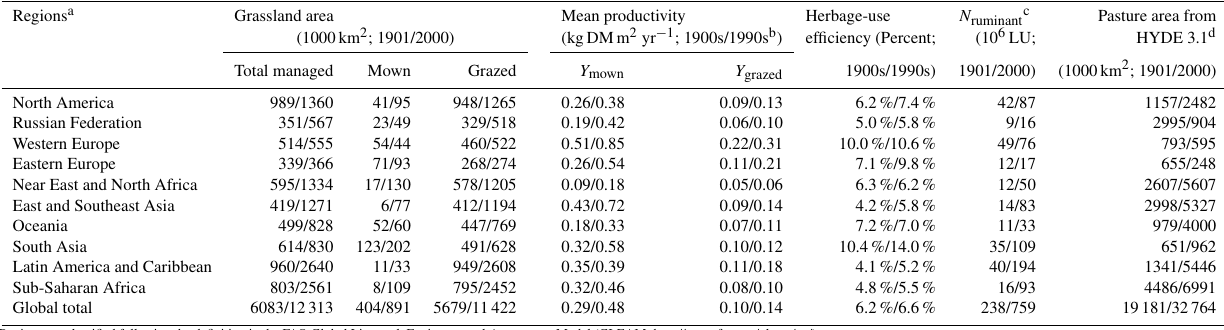
Table 3. Area, mean productivity, and herbage-use efficiency of managed grassland from this study, ruminant numbers, and pasture area from HYDE 3.1 dataset for 1901 and 2000 by regions and global total.